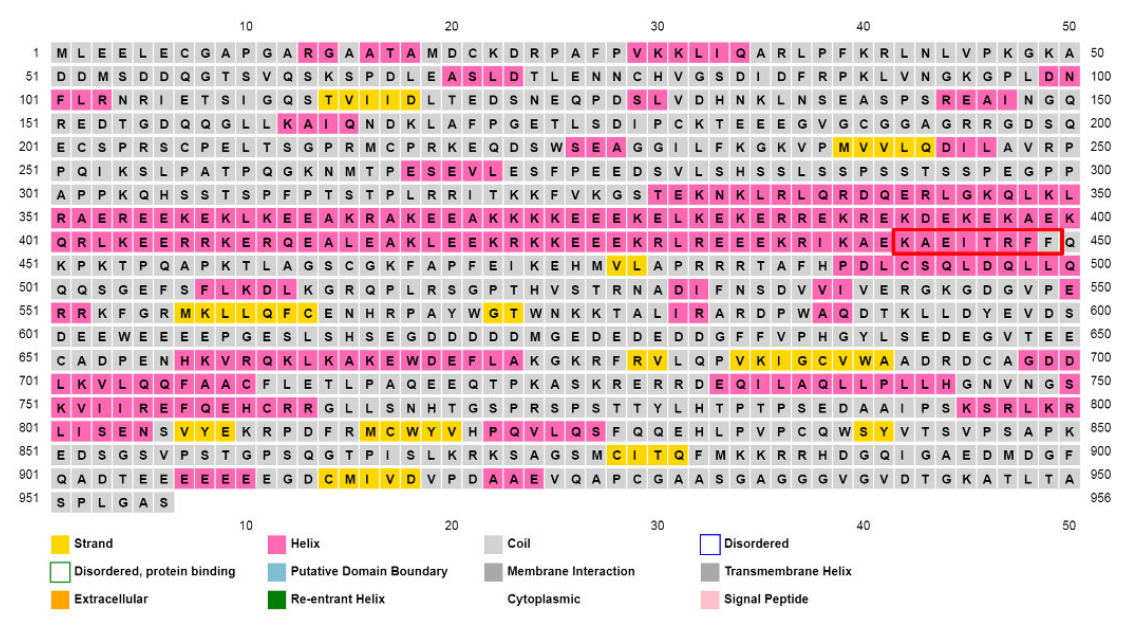
Figure 5. Secondary structure prediction analyses of human CAF-1 p150.